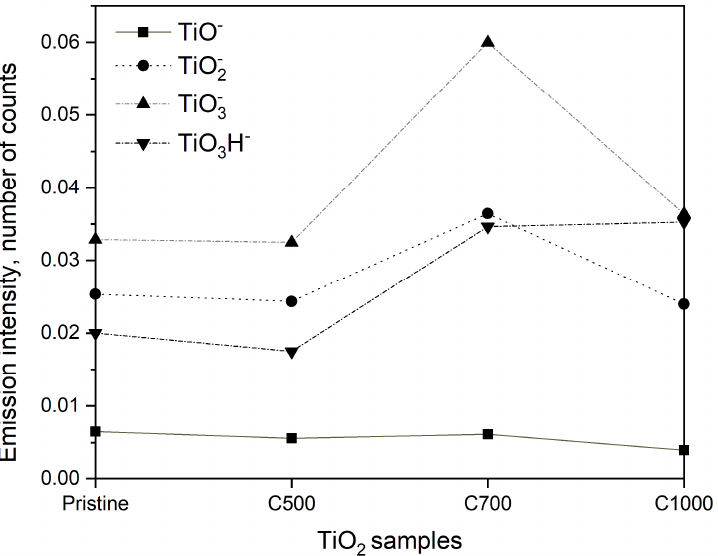
Figure 2. Emission of negative secondary ions from the cleaned surface of TiO 2 samples.